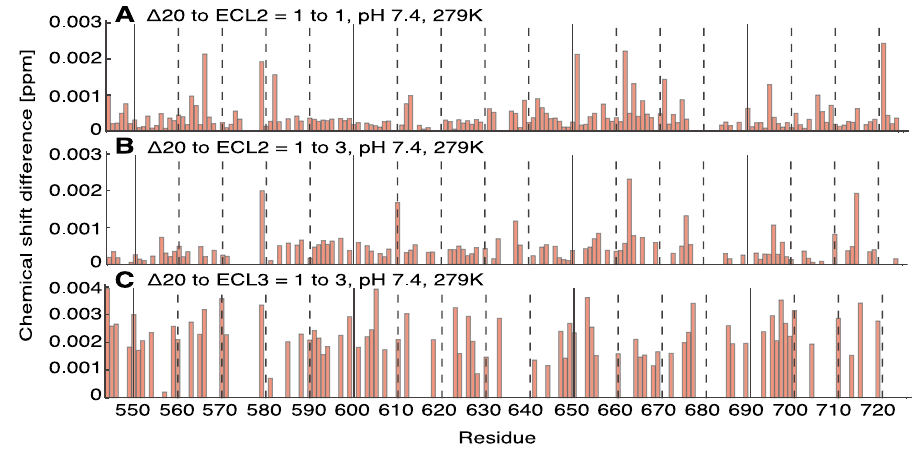
Fig 5. Chemical shiftperturbationsupontitrationof ECLs of S1PR2 to Nogo-A- Δ 20. Nogo-A- Δ 20 chemicalshift difference (CSD)of the combined 15 N and 1 H chemicalshifts betweenfree Nogo-A- Δ 20 and Nogo-A- Δ 20 in presenceof ECLs. A : 1 to 1 ratio (ECL2)at pH 7.4 and 6°C. B : 1 to 3 ratio (ECL2)at pH 7.4 and 6°C. C : 1 to 3 ratio (ECL3)at pH 7.4 and 6°C. The chemicalshift differences are smallerthan 0.005 ppm indicating no chemicalshift changes of Nogo-A- Δ 20 proteinupon ligand titration.